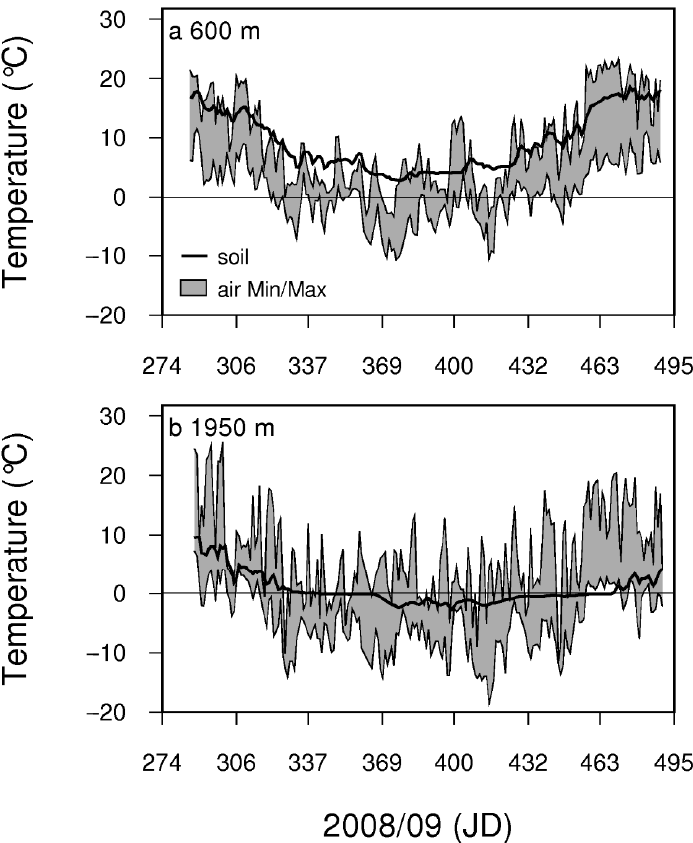
Figure 4. Temperature conditions in the Botanical Garden at 600 m a.s.l. ( a ) and at the field site at the timberline at 1950 m a.s.l. on Mt. Patscherkofel ( b ). The solid line shows the daily mean soil temperature at 5 cm depth, the grey area marks the daily minimum and maximum air temperatures measured at a height of 2 m.